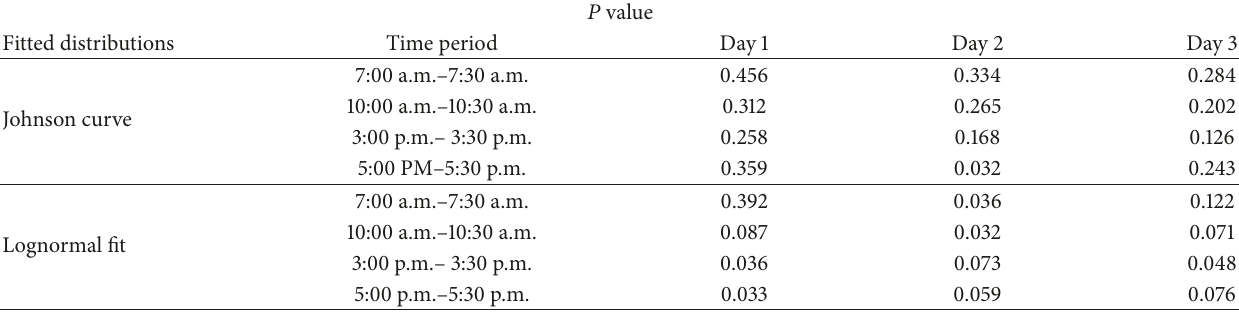
Table 1: 𝑃 value of Kolmogorov–Smirnov (KS) test with significance level of 0.05.